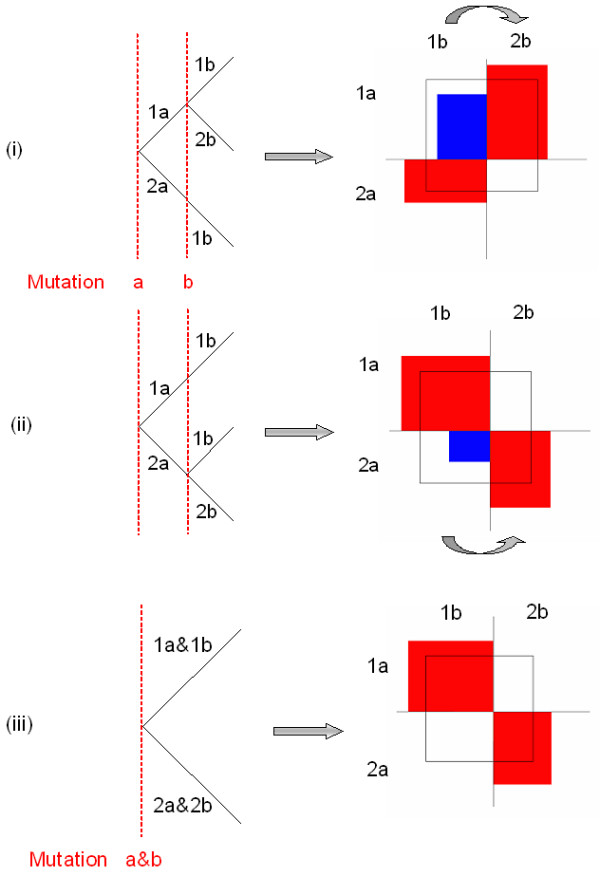
Use of MIDAS SNP/SNP plots to infer evolutionary history. The haplotype on which a SNP first arose is indicated by the estimated frequency of the haplotype carrying the most frequent alleles at both loci. (i) If this is less than expected, it implies that the SNP 2 arose on the haplotype carrying the common allele at SNP 1 (i.e. D'<0). (ii) If it is more common than expected then SNP 2 arose on the haplotype carrying the rare allele at SNP 1 (i.e. D' ≥ 0). (iii) If only two haplotypes are observed then perfect LD exists (r2 = 1). This may arise through bottlenecks, selection or simultaneous occurrence.